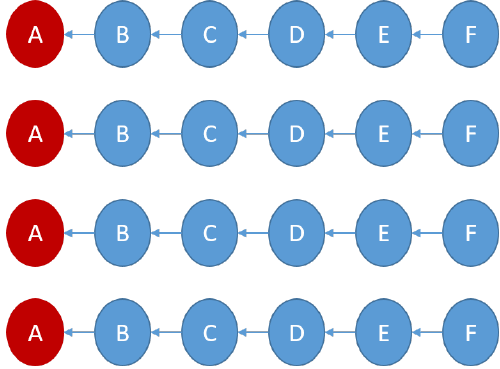
Figure 12. MD-Chain-SH formation.